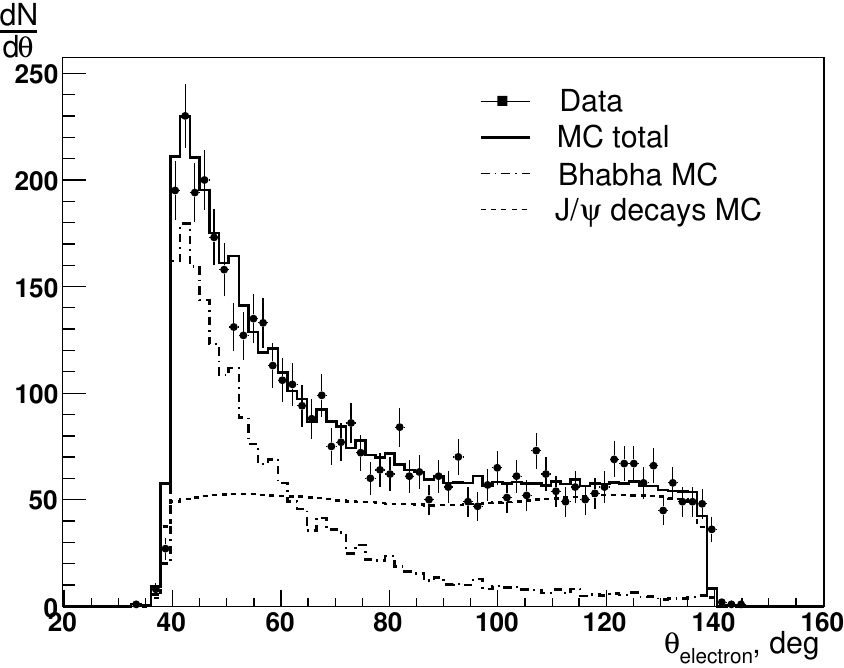
Figure 4 . Distribution of the electron polar angle at the energy 3097 MeV. The points show experimental data. The histograms correspond to MC simulation: the dashed-doted histogram represents Bhabha scattering, the dashed histogram represents a contribution of the J= resonance and their interference calculated according to eq. (4.7), and the solid-line histogram is the sum of the contributions.